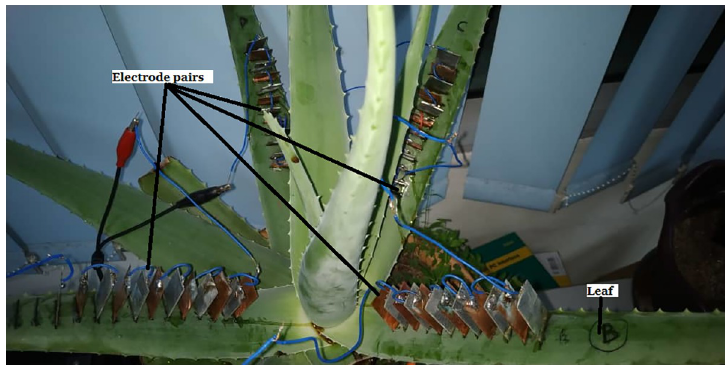
Fig 9. Experiment setup for series connection among leaves in which the connection by-passes the stem of the Aloe Vera.